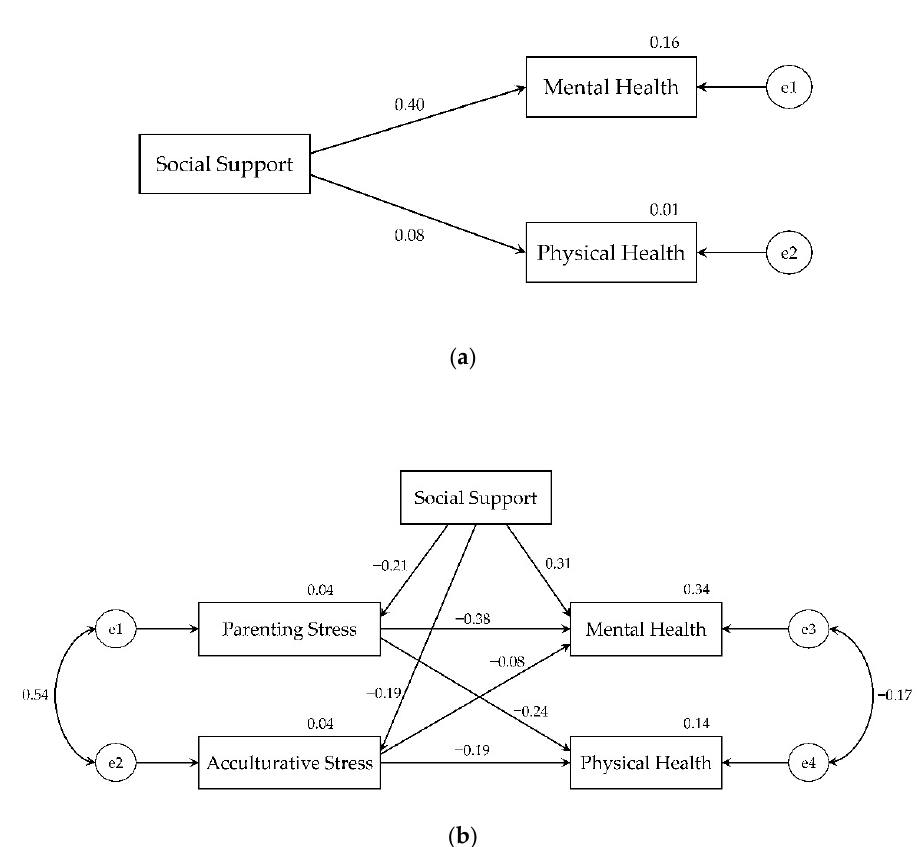
Figure 2. The results of structural model analysis ( n = 109; e1 − e4: error terms). ( a ) Step 1 of testing the mediating effect; ( b ) The final path model and step 2 of testing the mediating effect.